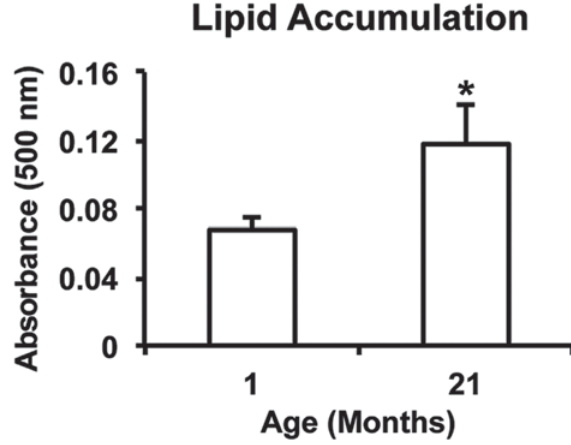
Figure 4- Lipid accumulation at day 21 of cultures from 1-month and 21-month rats grown on Ti discs. Data are presented as the mean±standard deviation (n=5). * (cid:76)(cid:81)(cid:71)(cid:76)(cid:70)(cid:68)(cid:87)(cid:72)(cid:86)(cid:3)(cid:86)(cid:87)(cid:68)(cid:87)(cid:76)(cid:86)(cid:87)(cid:76)(cid:70)(cid:68)(cid:79)(cid:79)(cid:92)(cid:3)(cid:86)(cid:76)(cid:74)(cid:81)(cid:76)(cid:191)(cid:70)(cid:68)(cid:81)(cid:87)(cid:3)(cid:71)(cid:76)(cid:73)(cid:73)(cid:72)(cid:85)(cid:72)(cid:81)(cid:70)(cid:72)(cid:86)(cid:3)(cid:69)(cid:72)(cid:87)(cid:90)(cid:72)(cid:72)(cid:81)(cid:3)(cid:70)(cid:72)(cid:79)(cid:79)(cid:86)(cid:3) (cid:73)(cid:85)(cid:82)(cid:80)(cid:3)(cid:20)(cid:16)(cid:80)(cid:82)(cid:81)(cid:87)(cid:75)(cid:3)(cid:68)(cid:81)(cid:71)(cid:3)(cid:21)(cid:20)(cid:16)(cid:80)(cid:82)(cid:81)(cid:87)(cid:75)(cid:3)(cid:85)(cid:68)(cid:87)(cid:86)(cid:3)(cid:11)(cid:83)(cid:148)(cid:19)(cid:17)(cid:19)(cid:24)(cid:12)